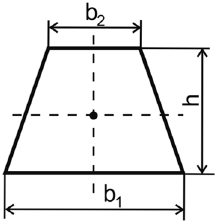
Figure 3. Cross ‐ section of the sample for flexural strength testing. Figure 3. Cross-section of the sample for flexural strength